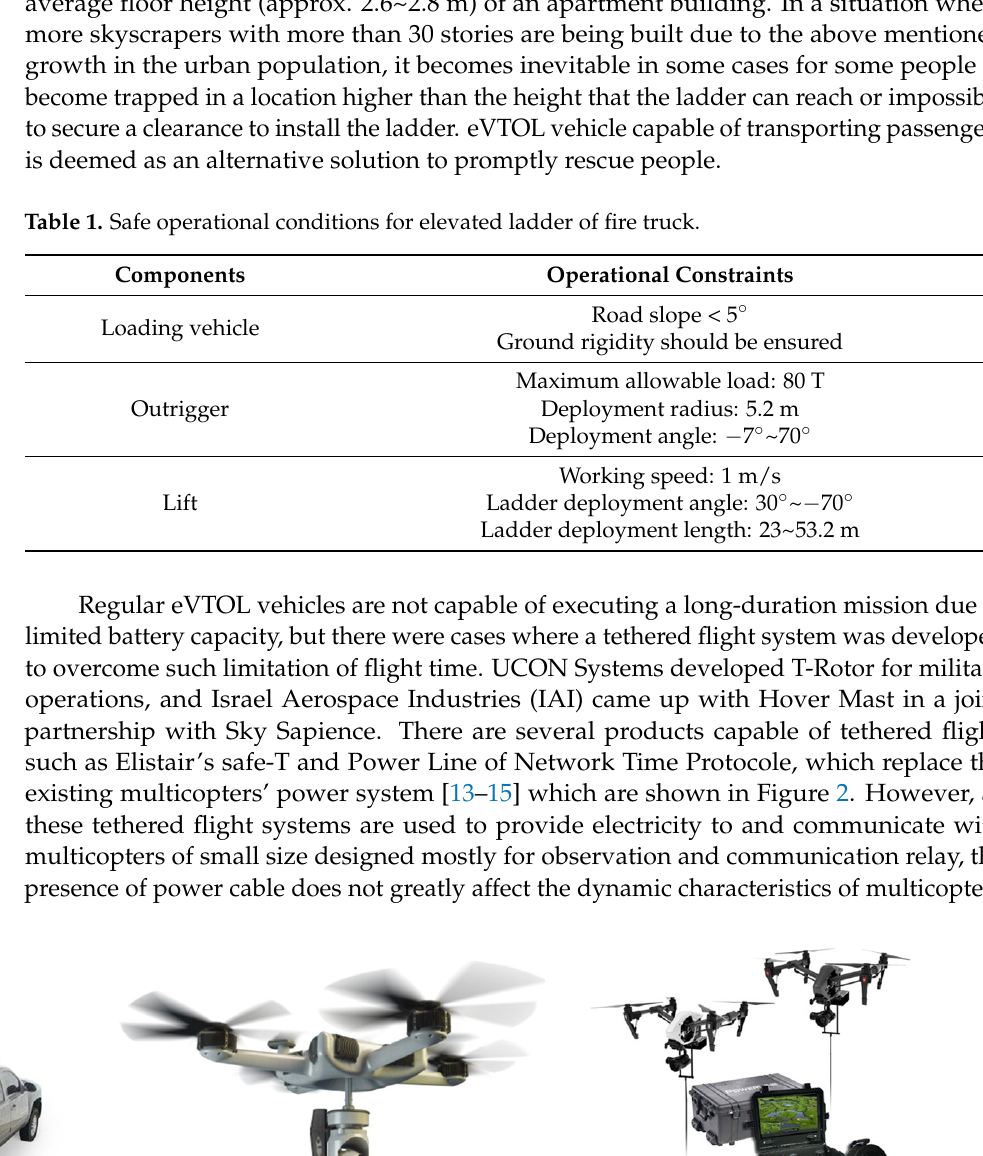
Table 1. Safe operational conditions for elevated ladder of fire truck.